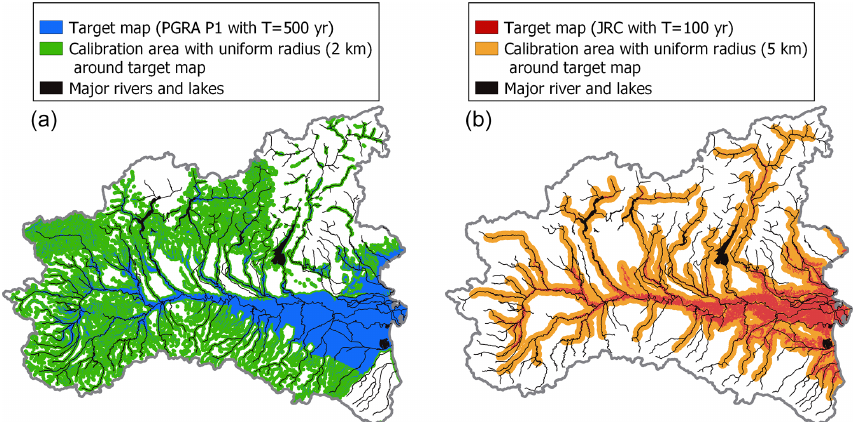
Figure 5. Calibration areas: 2km buffer (green) and PGRA P1 flood-prone areas (blue) used for the classification problem (a) ; 5km buffer (orange) and JRC 100 flood-prone areas (red) used for the regression problem (b)